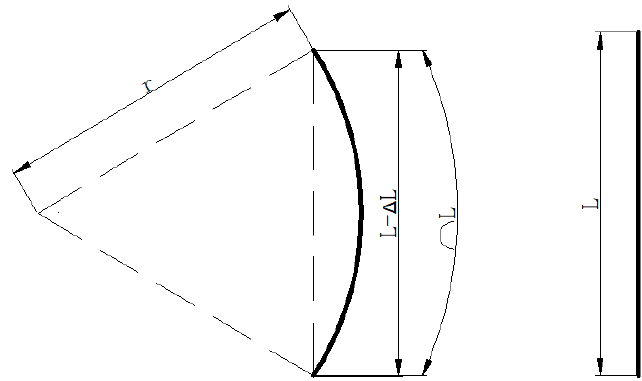
Figure 5. Schematic diagram of the bending deformation of the fiber Bragg grating sensor.